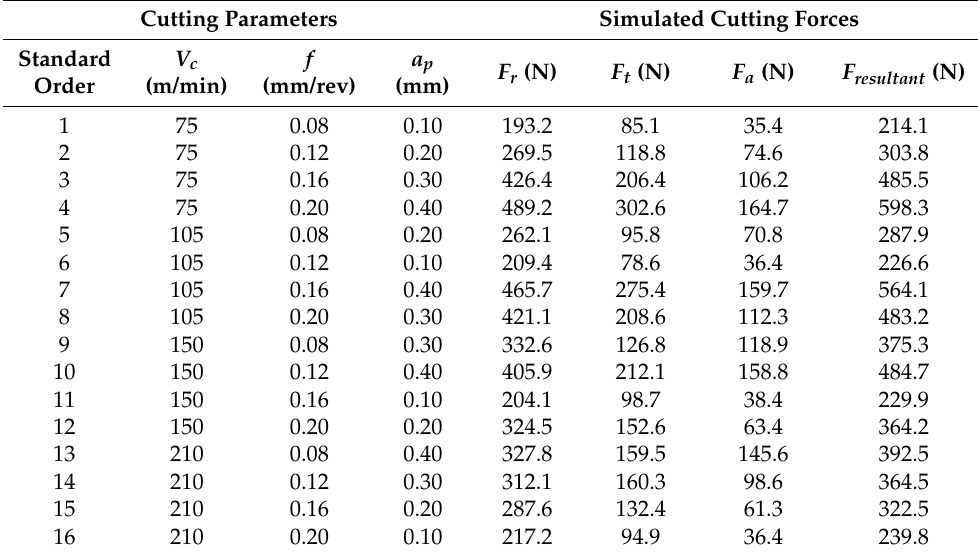
Table 4. FE model results for the force components. Cutting